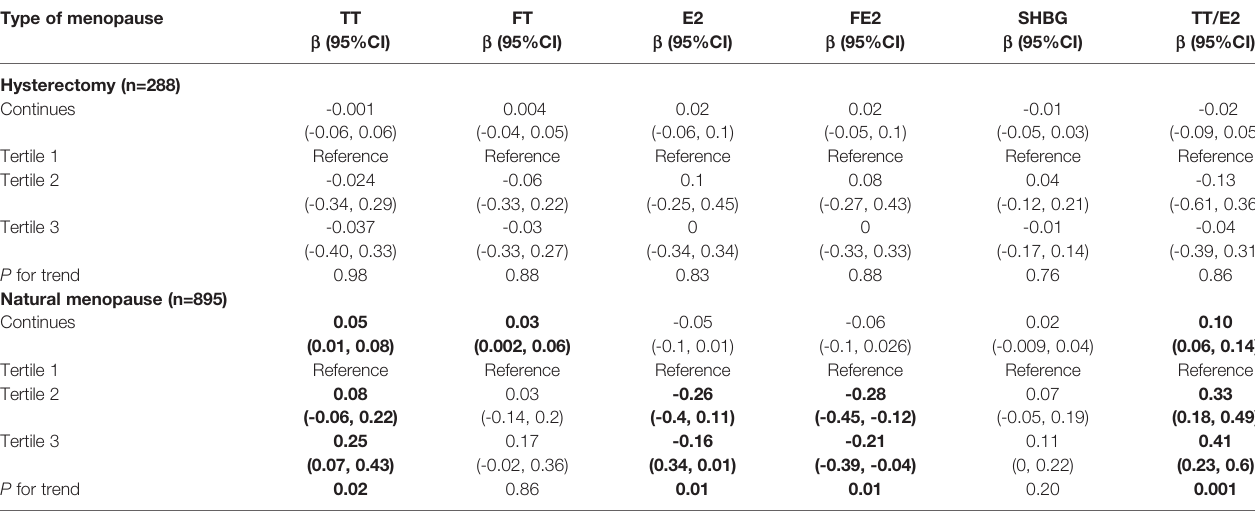
TABLE 3 | Association between E-DII and sex hormones strati fi ed by type of menopause. Type of menopause